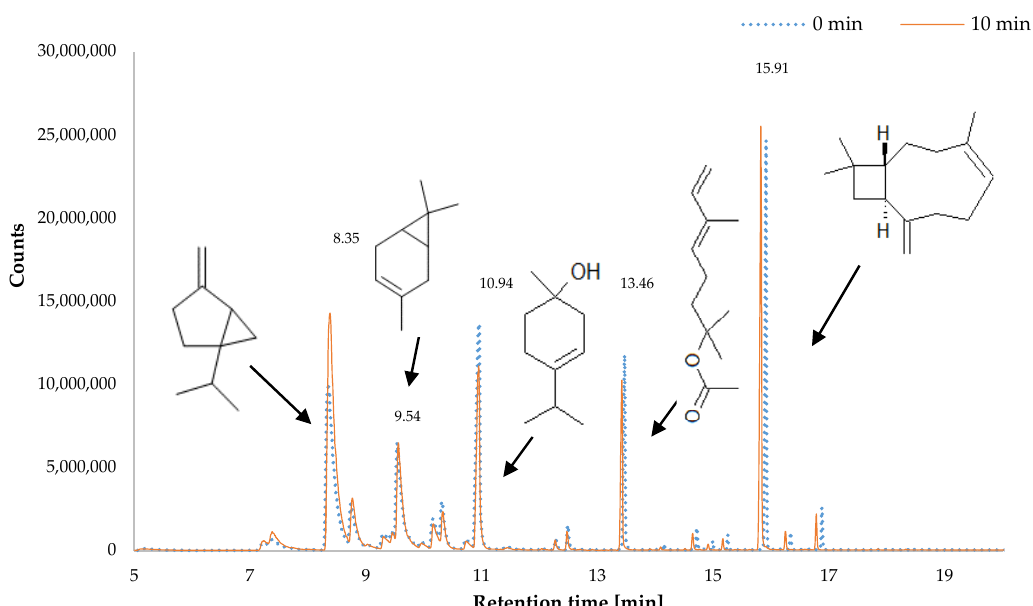
Figure 2. Chromatograms SPME-GC (Head Space–Solid Phase Microextraction coupled with Gas Chromatography) for the volatile fraction of leaves of Origanum majorana L. leaves depending on the time ozonation in one day from ozonation (n = 3).